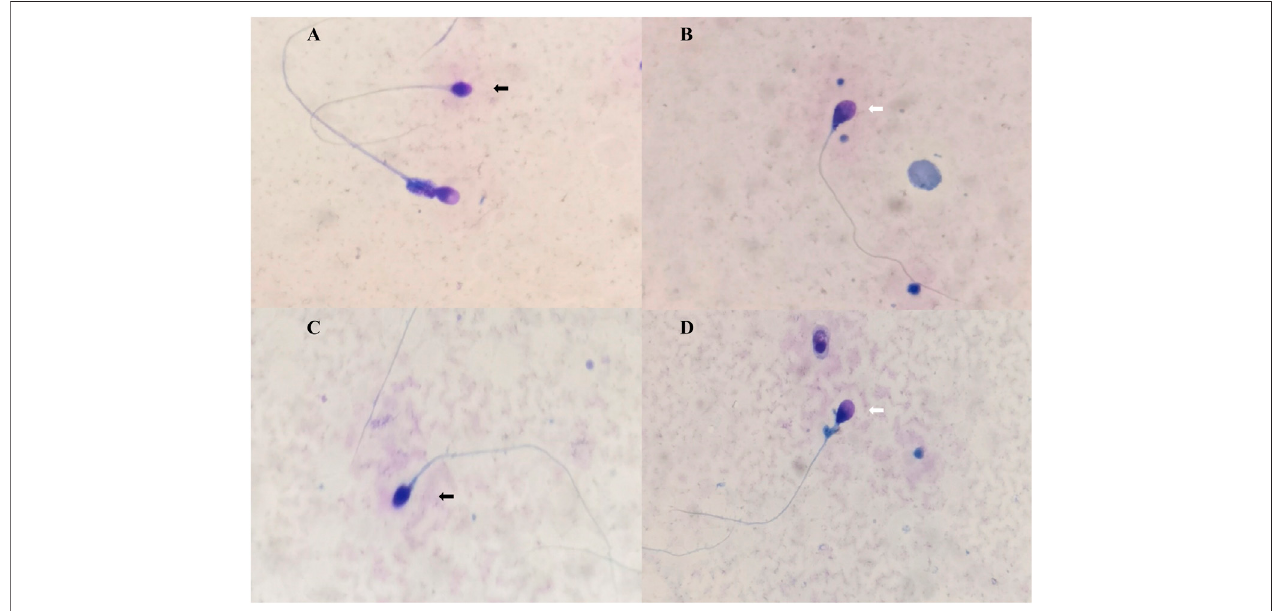
FIGURE 1 | Morphology sperm images of the case. (A,C) The black arrow indicates a rounded acrosomeless head. The white arrow indicates that the pyriform sperm head and midpiece comments are thick. (B,D) The black arrow indicates round without acrosome. The white arrow indicates a pyriform sperm head, and less than 40% of the head is occupied by the acrosome.